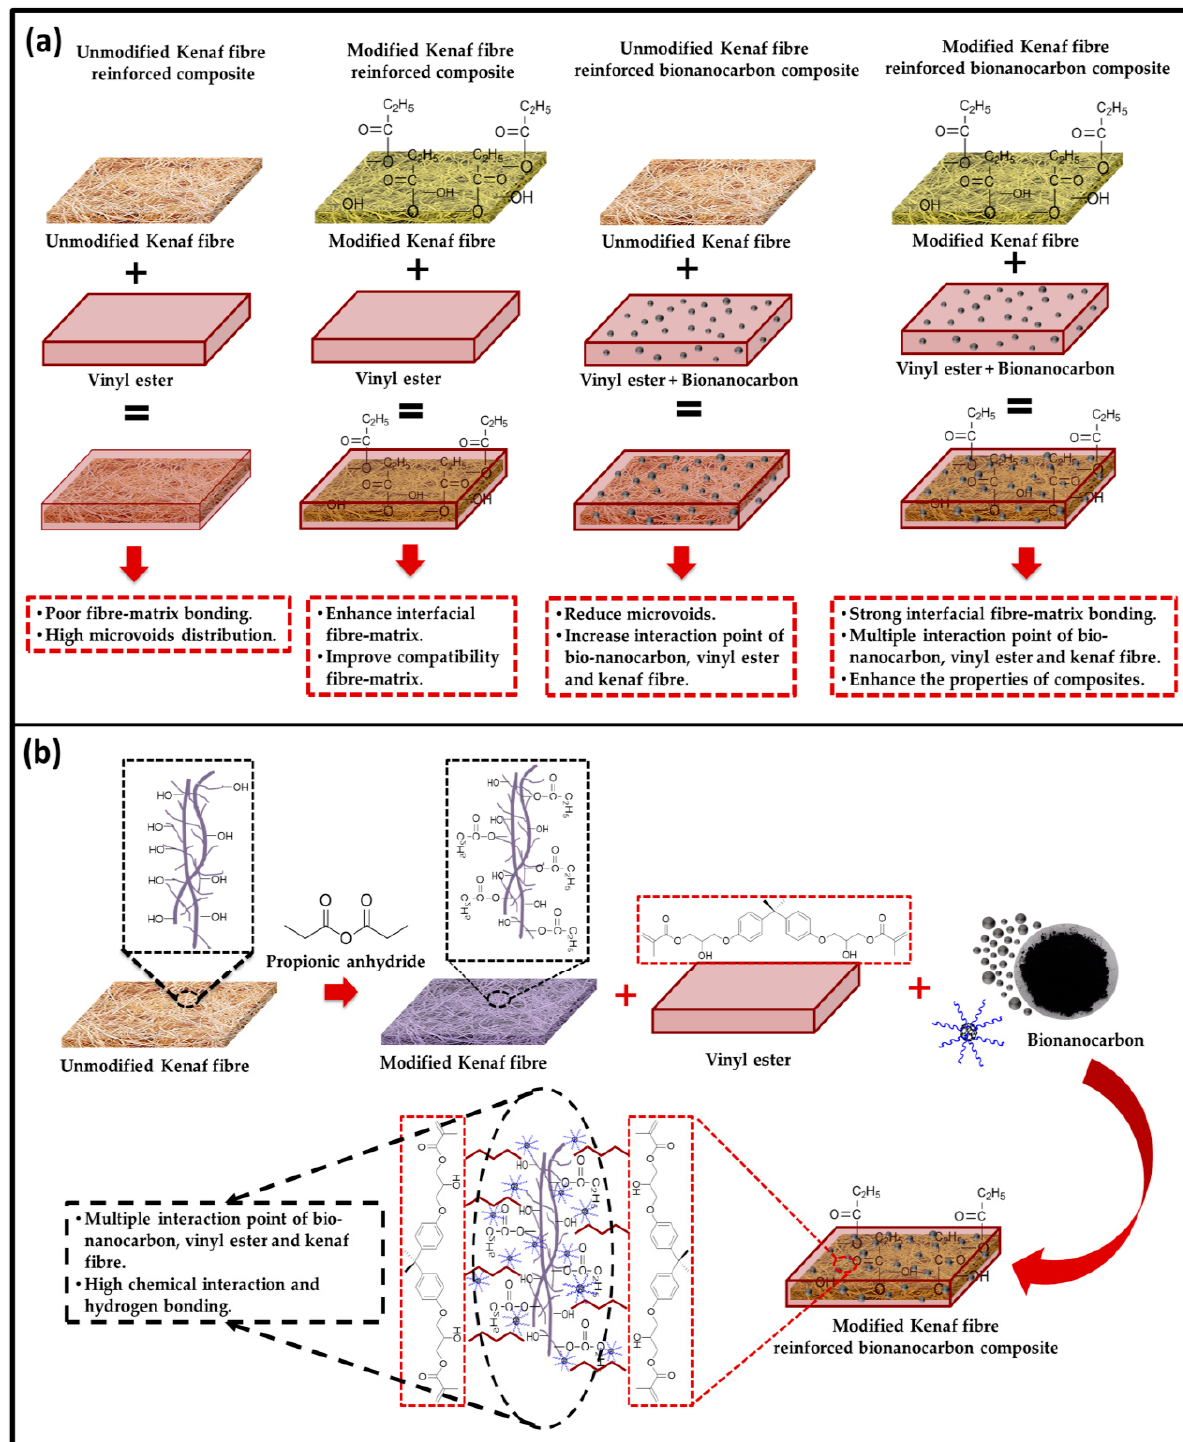
Figure 9. Possible Mechanism of bionanocarbon enhanced reinforced kenaf-based nanocomposites indicating ( a ) Unmod- ified and modified kenaf fibre reinforced composite with bionanocarbon ( b ) propionic anhydride modified Kenaf fibre reinforced composite with bionanocarbon.